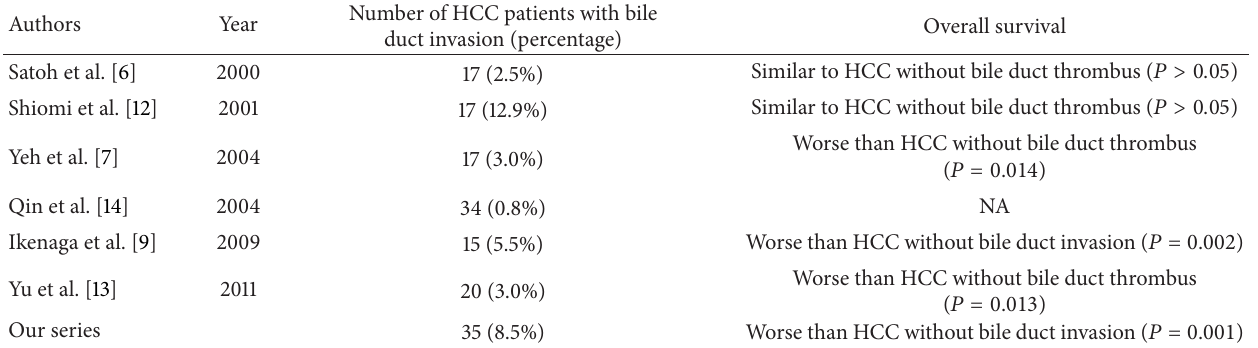
Table 5: Summary of the previous reports of surgical outcome of HCC with bile duct